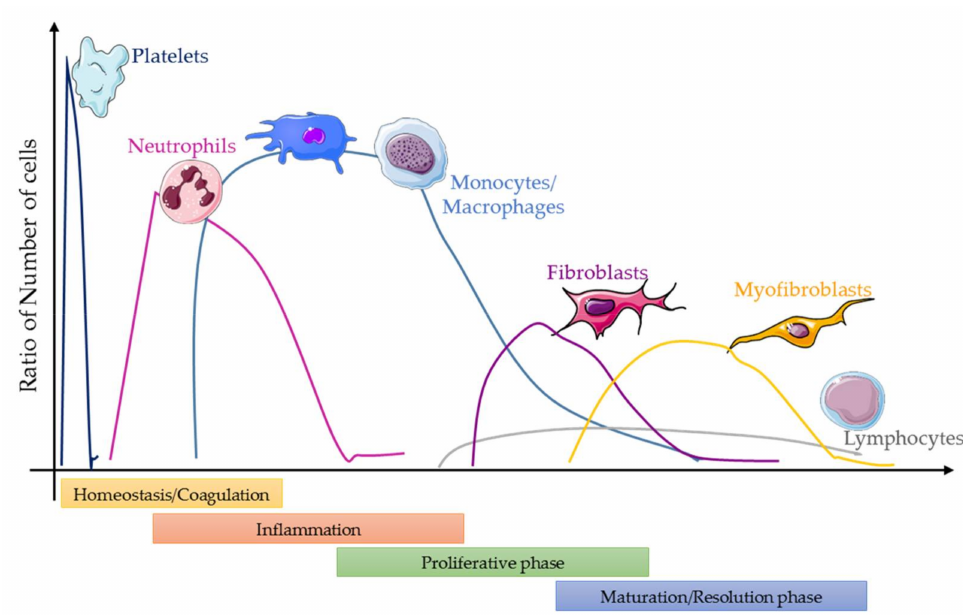
Figure 1. Time lapse of cells recruited into a wound. During the first phase, platelets and neu- trophils are recruited, and then monocytes are recruited and infiltrate the tissue and differentiate into macrophages; resident macrophages can also proliferate. Altogether, this leads lead to fibrocyte recruitment and fibroblast proliferation and the posterior conversion to myofibroblasts. Other cells such as lymphocytes—mainly T cells—are also recruited in low numbers at the late stages. This figure does not show the NK, dendritic cells and mast cells; usually their numbers are extremely low, but still they can play an important role on the